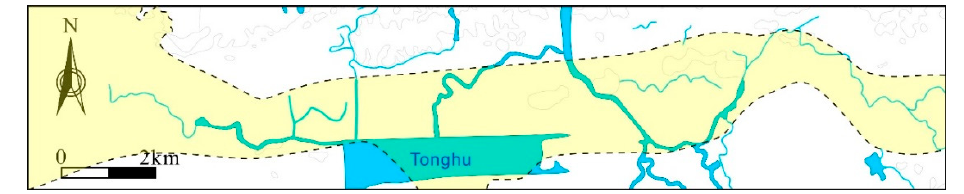
Figure 5. Distribution of ancient rivers in the study area .